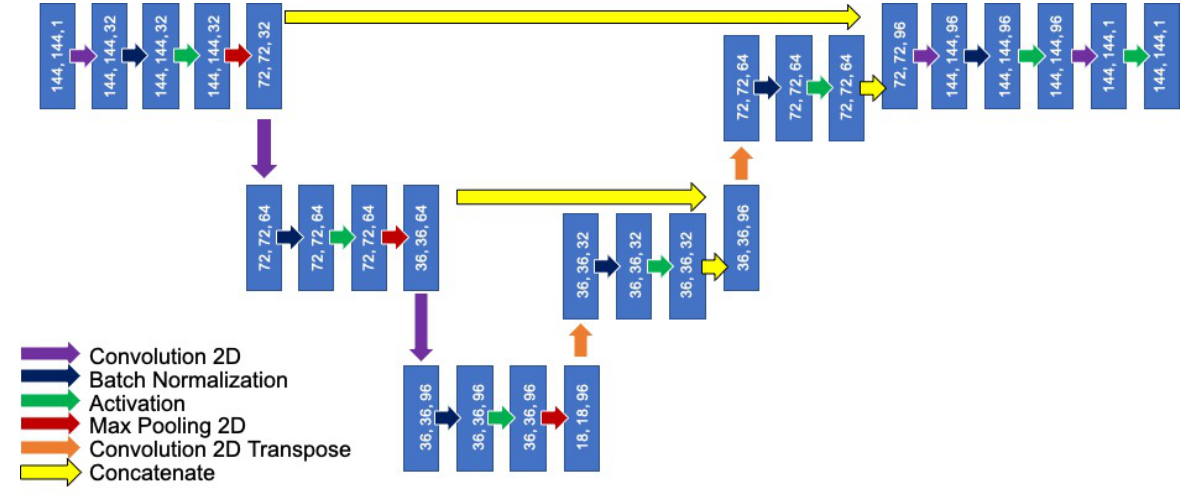
Figure 3. Architecture of convolutional neural network (CNN) used to segment the